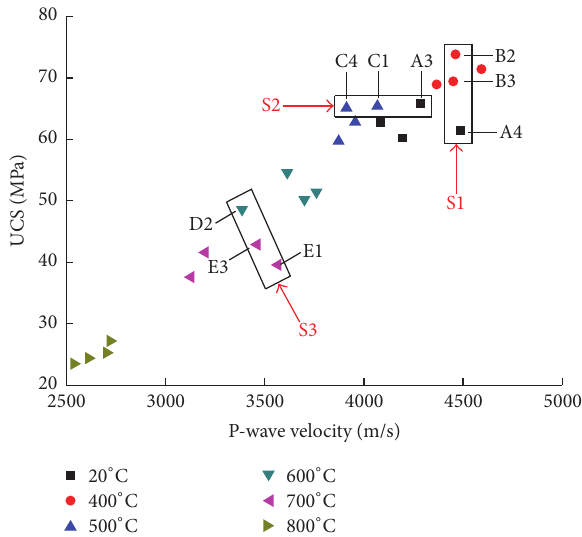
Figure 4: Relationship between the P-wave velocity and UCS.